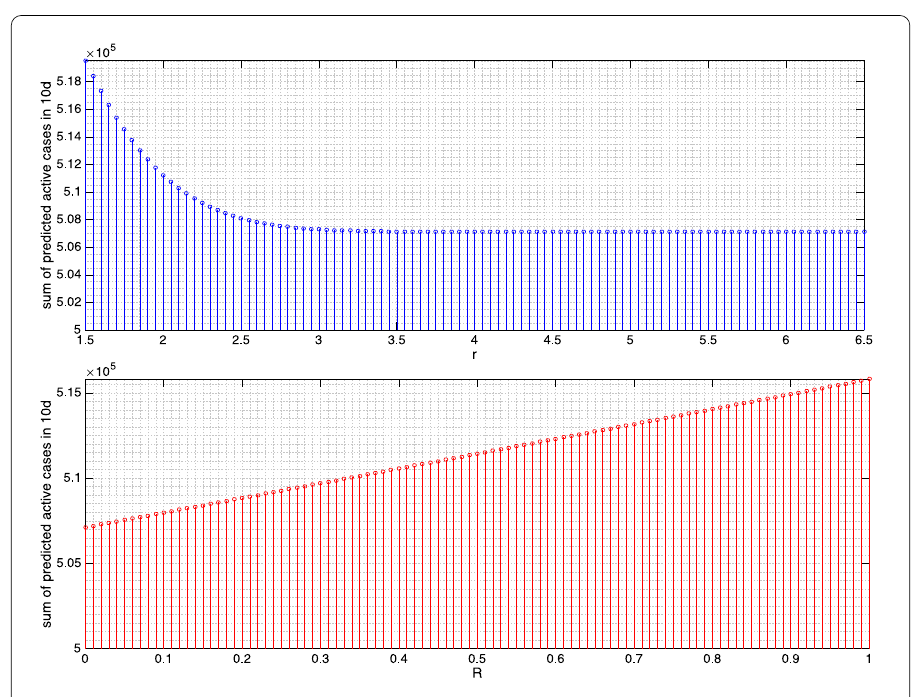
Figure 4 Sum of the predicted active cases for the next 10d (April 12–21, 2020) in Germany under variations of r and R . The value r = 3 leads to the reduction to 98.31%, R ≈ 1/4,1/3,1/2,3/4 to 98.73%, 98.86%, 99.15%, and 99.57%, respectively